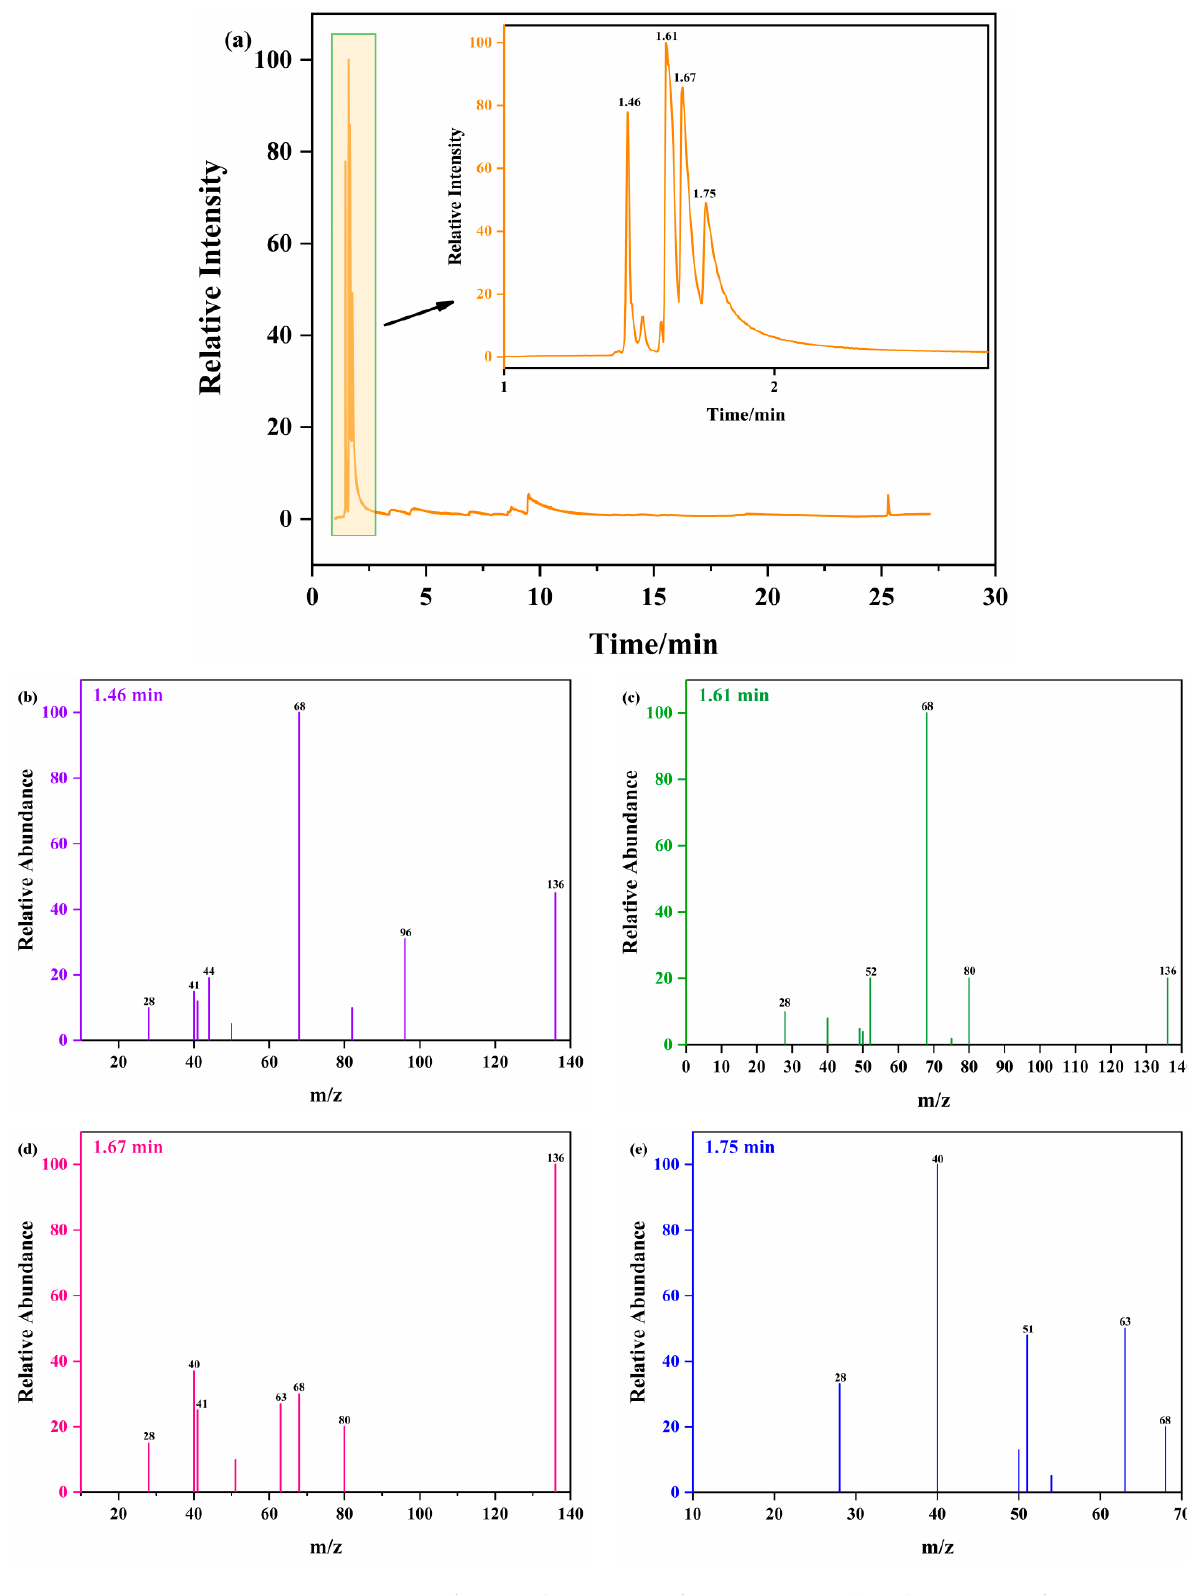
Figure 10. PY-GC/MS pyrolysis spectra of ATRZ at 400 °C ( a ) and MS spectra of ATRZ at 1.46 min ( b ), 1.61 min ( c ), 1.67 min ( d ), and 1.75 min ( e ). According to the total ion fragmentation chromatogram of ATRZ shown in Figure 10 and the corresponding mass spectra of the chromatographic peaks of the four main reten- tion times, the pyrolysis path of ATRZ was inferred, as shown in Figure 11. ATRZ was